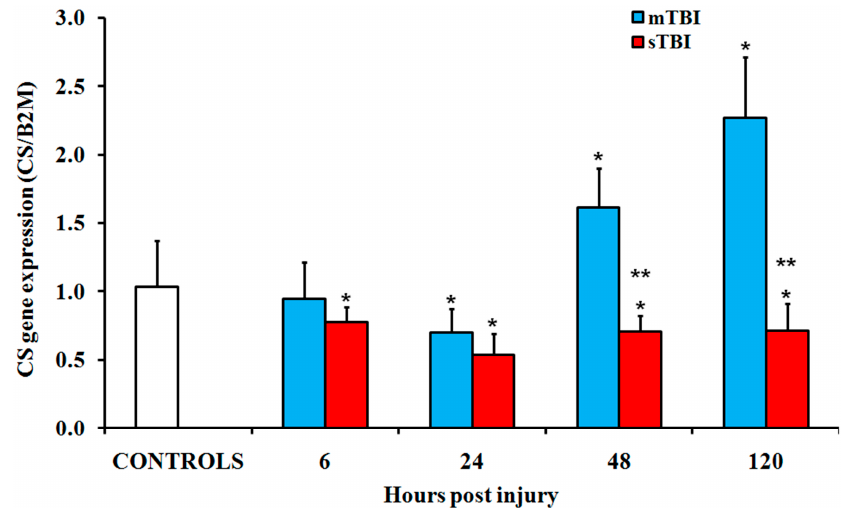
Figure 4. Changes in the expression of the gene encoding for citrate synthase (CS) in the brain tissue homogenates of rats receiving a TBI of different severities (mTBI or sTBI) at various times post-injury. Values are the mean of six animals. Standard deviations are represented by vertical bars. Gene expressions were calculated relatively to the expression of the housekeeping gene β -2-microtubulin (B2M). * significantly different from the controls, p < 0.05. ** significantly different from the corresponding time of the mTBI rats p < 0.05. Int. J. Mol. Sci. 2019 , 20 , x FOR PEER REVIEW